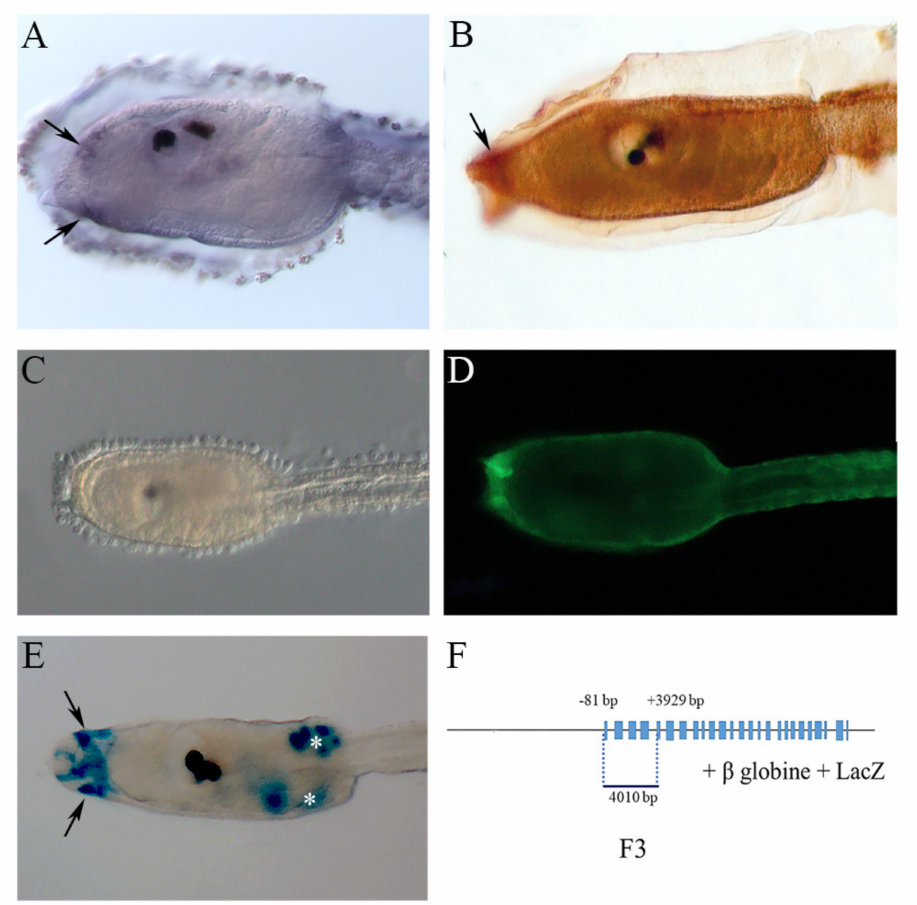
Figure 1. NOS and NO localization in Ciona larval palps (arrows). ( A ) In situ hybridization of Nos gene in sensory vesicle at the early to mid-larval stage. ( B ) Immunochemistry assay of NOS, using antibody uNOS, at the late larval stage. ( C , D ) NO localization using DAF-FM-DA at the late larval stage. Bright field ( C ) and dark field ( D ) of the same larva. ( E ) Transgenic assay of Ciona F3 Nos regulatory region. ( F ) Schematic representation of F3 construct and F3 regulatory region position along the Nos gene locus. The white asterisk indicates an ectopic signal in mesenchymal